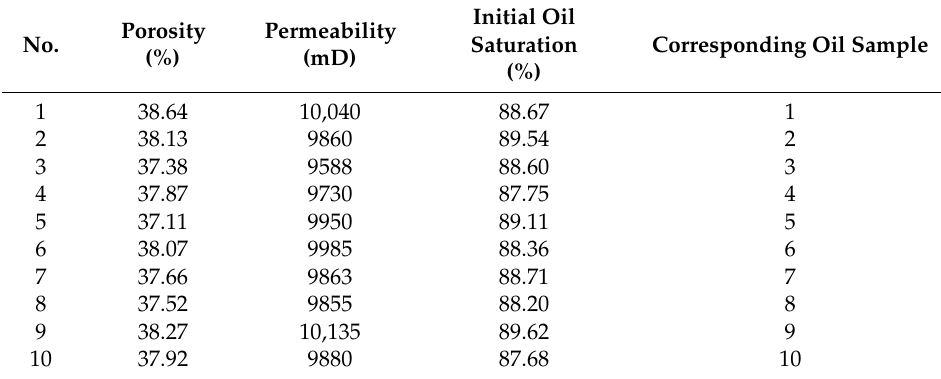
Table 3. Parameters for sandpack depletion experiments.